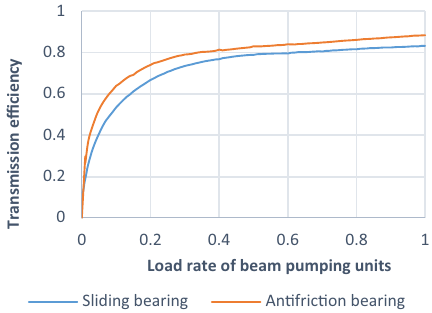
Fig. 1 Transmission efficiency curve of ground equipment